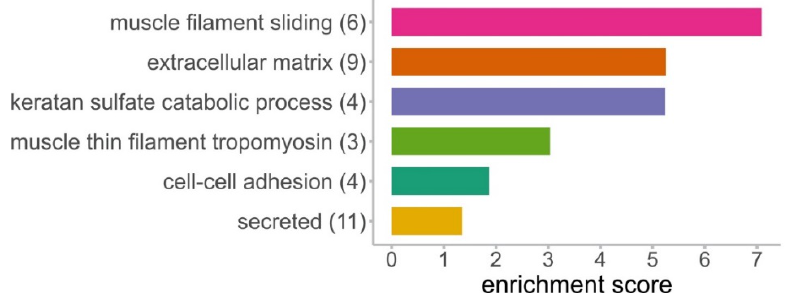
old vs. young testicular proteomes. Data were z-scored prior to the analysis. ( B ) PANTHER analysis of differentially abundant proteins using GO biological process as database. The numbers indicate the percentage of proteins annotated with the corresponding GO term.